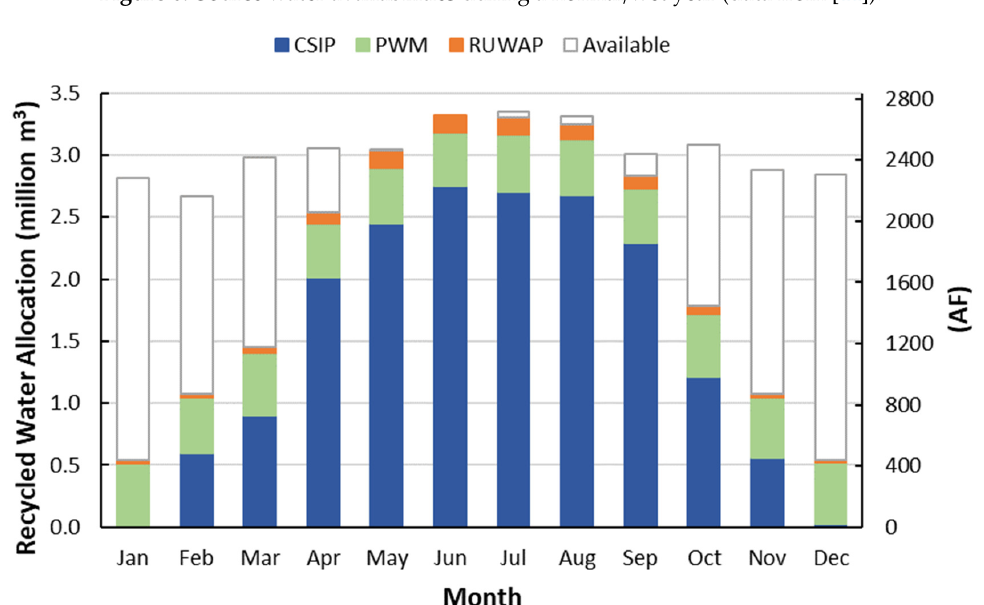
Figure 7. Recycled water distribution by project during a normal/wet year, showing irrigated agriculture (CSIP), potable water recharge (PWM), and urban irrigation (RUWAP). A substantial amount of water is available during the off-peak growing season (data from [44]).